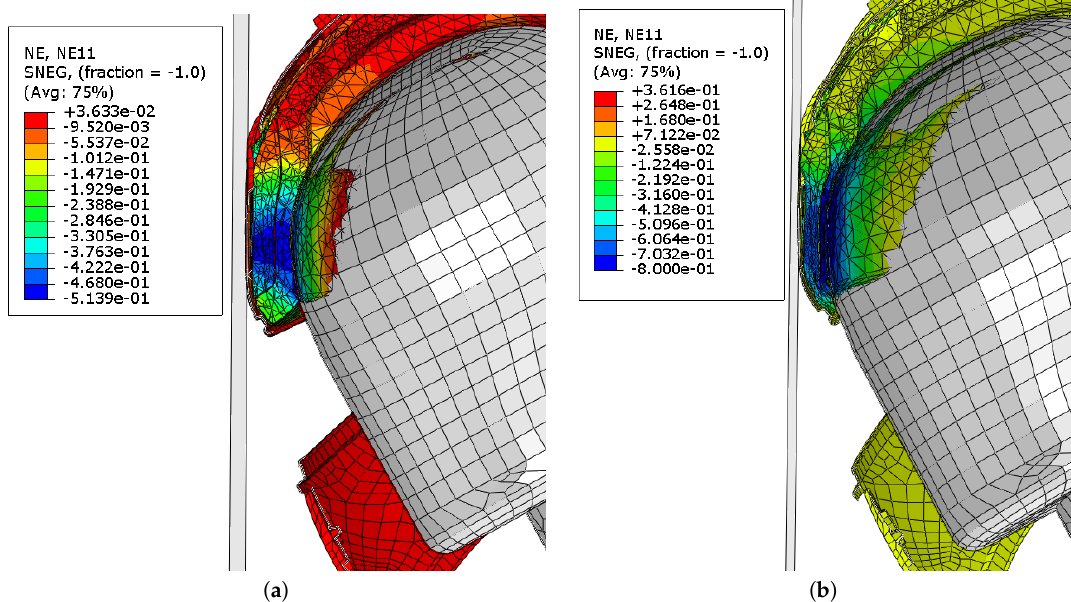
Figure 5. Sagitall cut view of the helmet-headform system at the moment of maximum